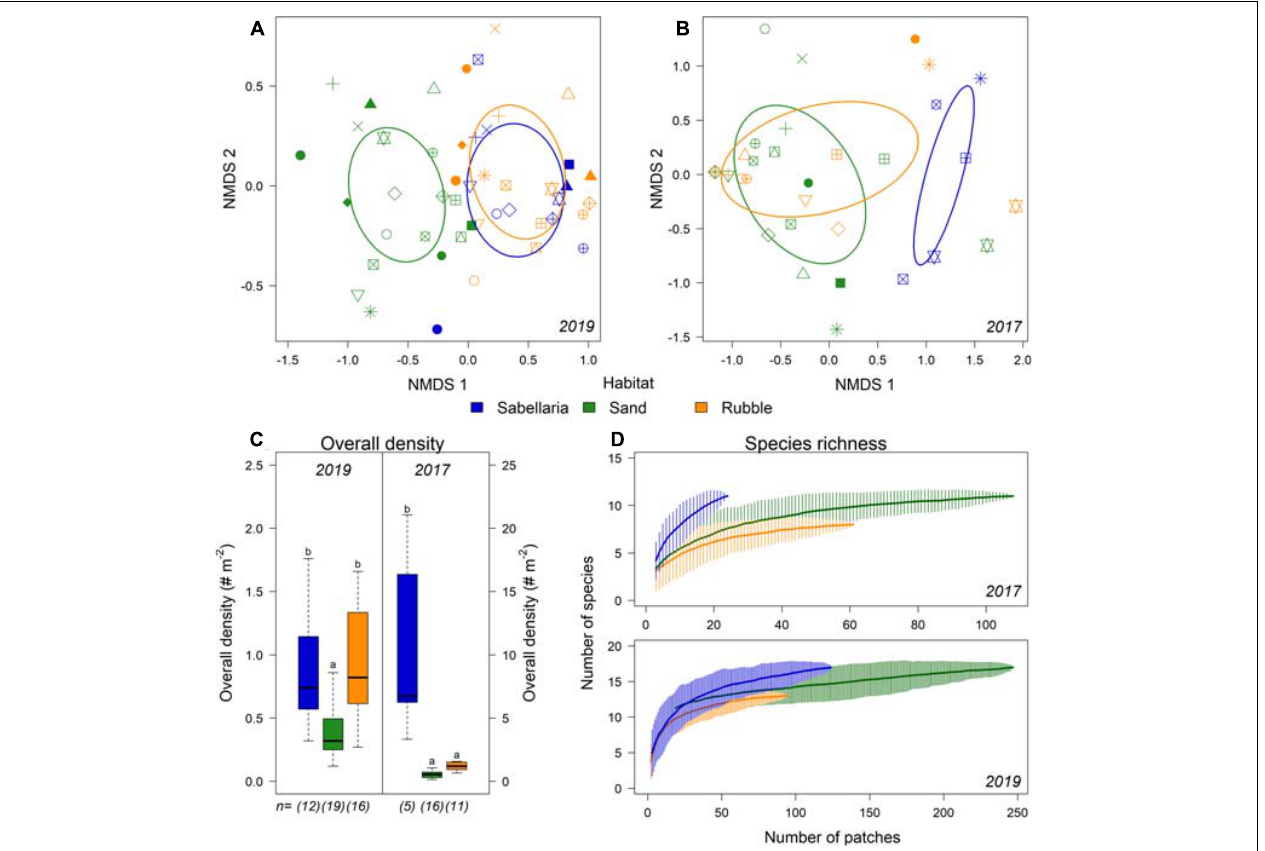
FIGURE 6 | Differences in community composition between the different habitat types Sabellaria (blue), Sand (green), and Rubble (orange). (A) NMDS of epifauna data gathered in the 2019 campaign and (B) in the 2017 campaign. Each habitat type observed within a transect is displayed separately, with the different symbols representing the video transects. (C) overall density (# Nm − 2 ) and species richness (Nm − 2 ) per habitat type for 2019 and (D) for 2017. n represents the number of different transects with this habitat type. Significant differences are represented by different